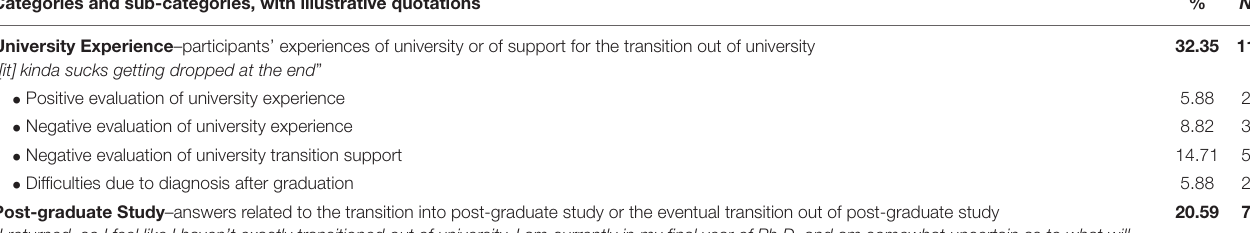
TABLE 6 | Content analysis of participants’ additional open comments about their transition out of university, showing categories (in bold) and sub-categories (bullet pointed). Categories and sub-categories, with illustrative quotations %